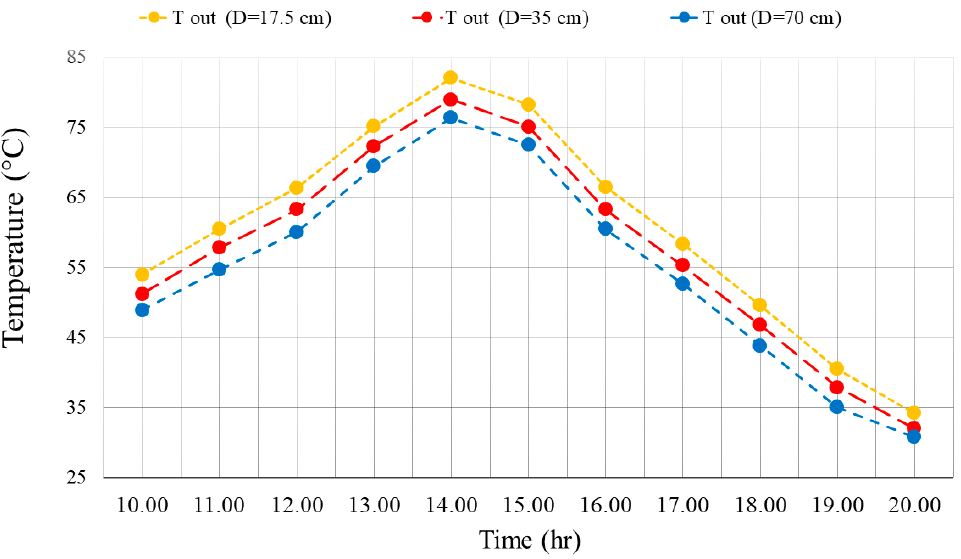
Figure 8. Outlet TEM variations of the Tr-W for different dimensions of the wall hole without PCM at different times of the day in summer.